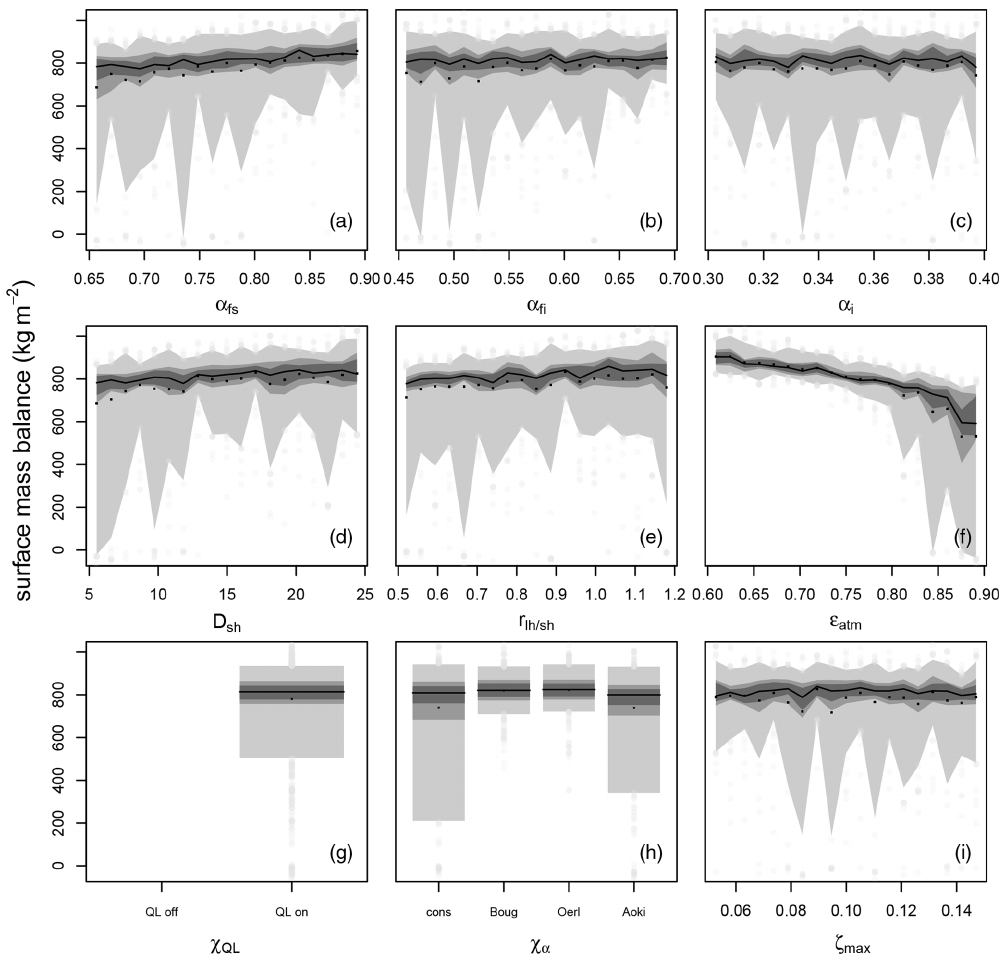
Figure 7. The ensemble statistics for the surface mass balance of the Q Lon sub-ensemble for region 5 (west 1000–2000m) in the LGM. The 5th and 95th, 25th and 75th, 33rd and 66th, and 50th quantiles are shown in progressively darker shading. Black points represent the ensemble mean, and the grey points correspond to the rest of the ensemble, apart from outliers (max five per bin allowed), which are removed to improve readability. Each plot represents the range of one parameter with α fs , α fi , and α i in the top row; D SH , r lh / sh , and (cid:15) atm in the middle; and Q Lon / off , χ α , and ζ max at the bottom. As Q Lon / off and χ α have two and four discrete values, respectively, the parameter range is not split into 20 intervals. Figure A2 shows a similar plot for the entire LGM